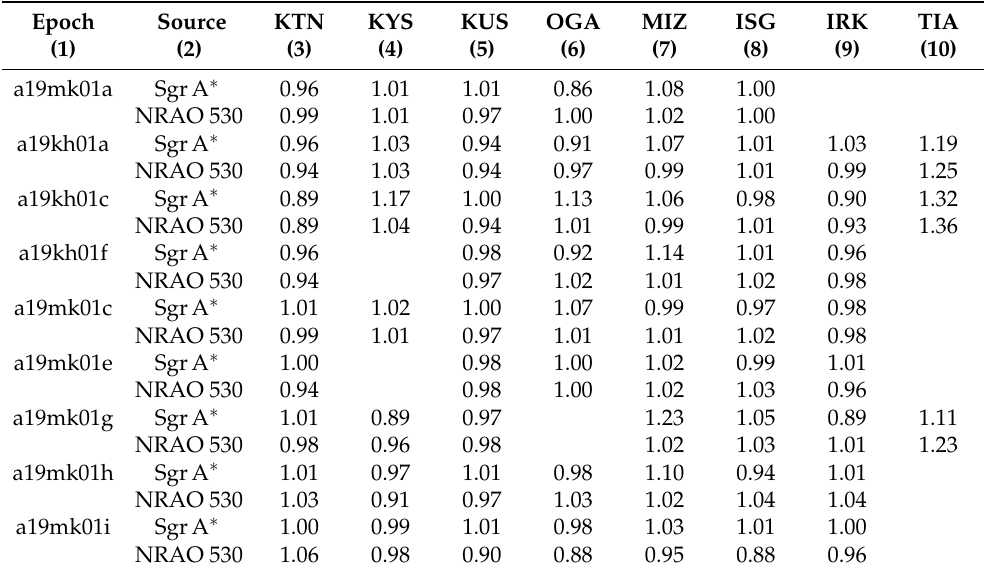
Table 2. Amplitude gain correction factors for each